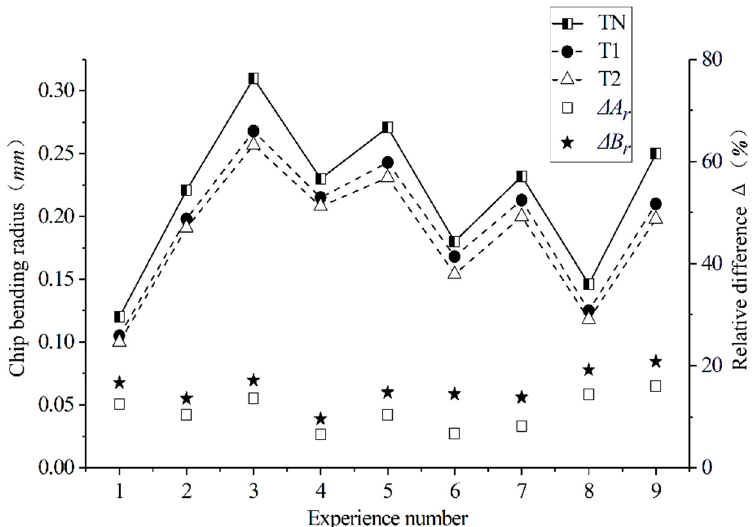
Figure 8. Comparison of the chip curl radius generated by the different cutting parameters of different tools.